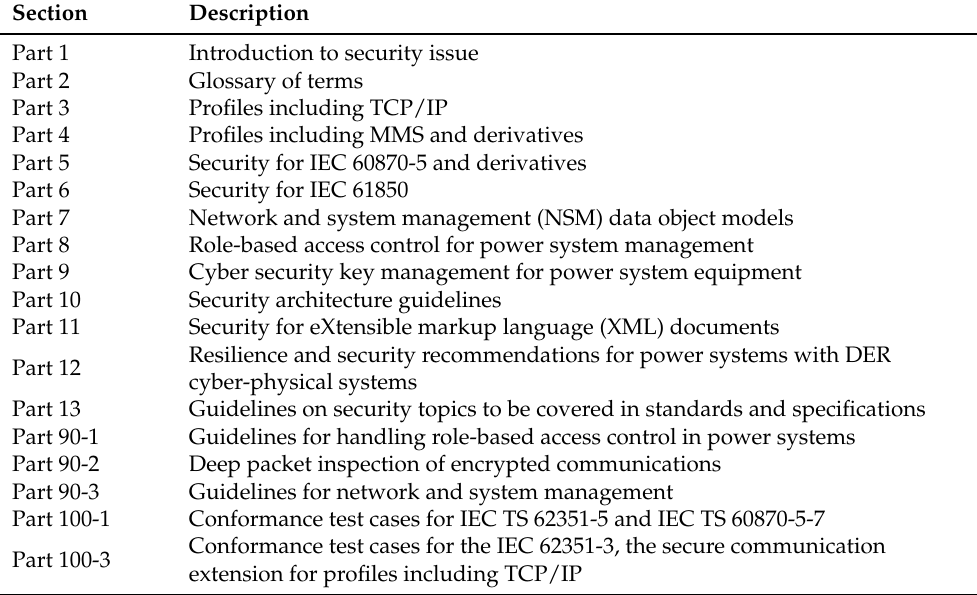
Table 1. Summary of IEC 62351